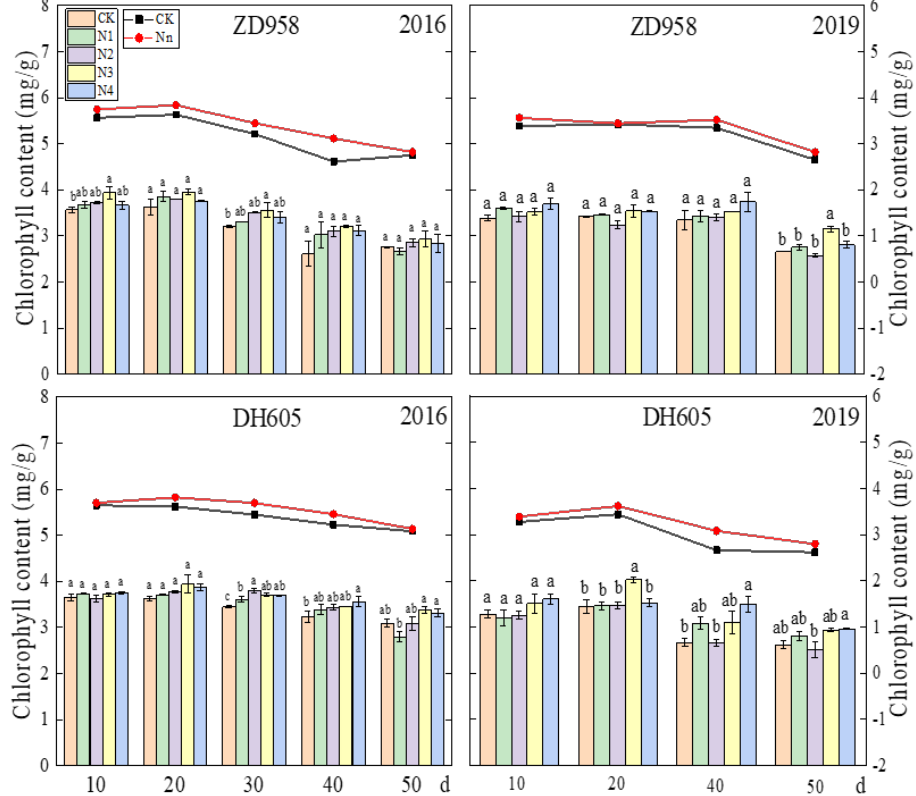
Figure 3. Effects of N treatments on chlorophyll content of ear leaves in maize in 2016 and 2019. The chlorophyll content was measured every 10 days after silking (as shown on the left axis). Black and red lines indicate the chlorophyll content under the control and the late split N treatments (average value), respectively (as shown on the right axis). One-way analysis of variance with Duncan’s new multiple range test was conducted to assess the statistical patterns. Different letters indicate a significant difference ( p < 0.05).